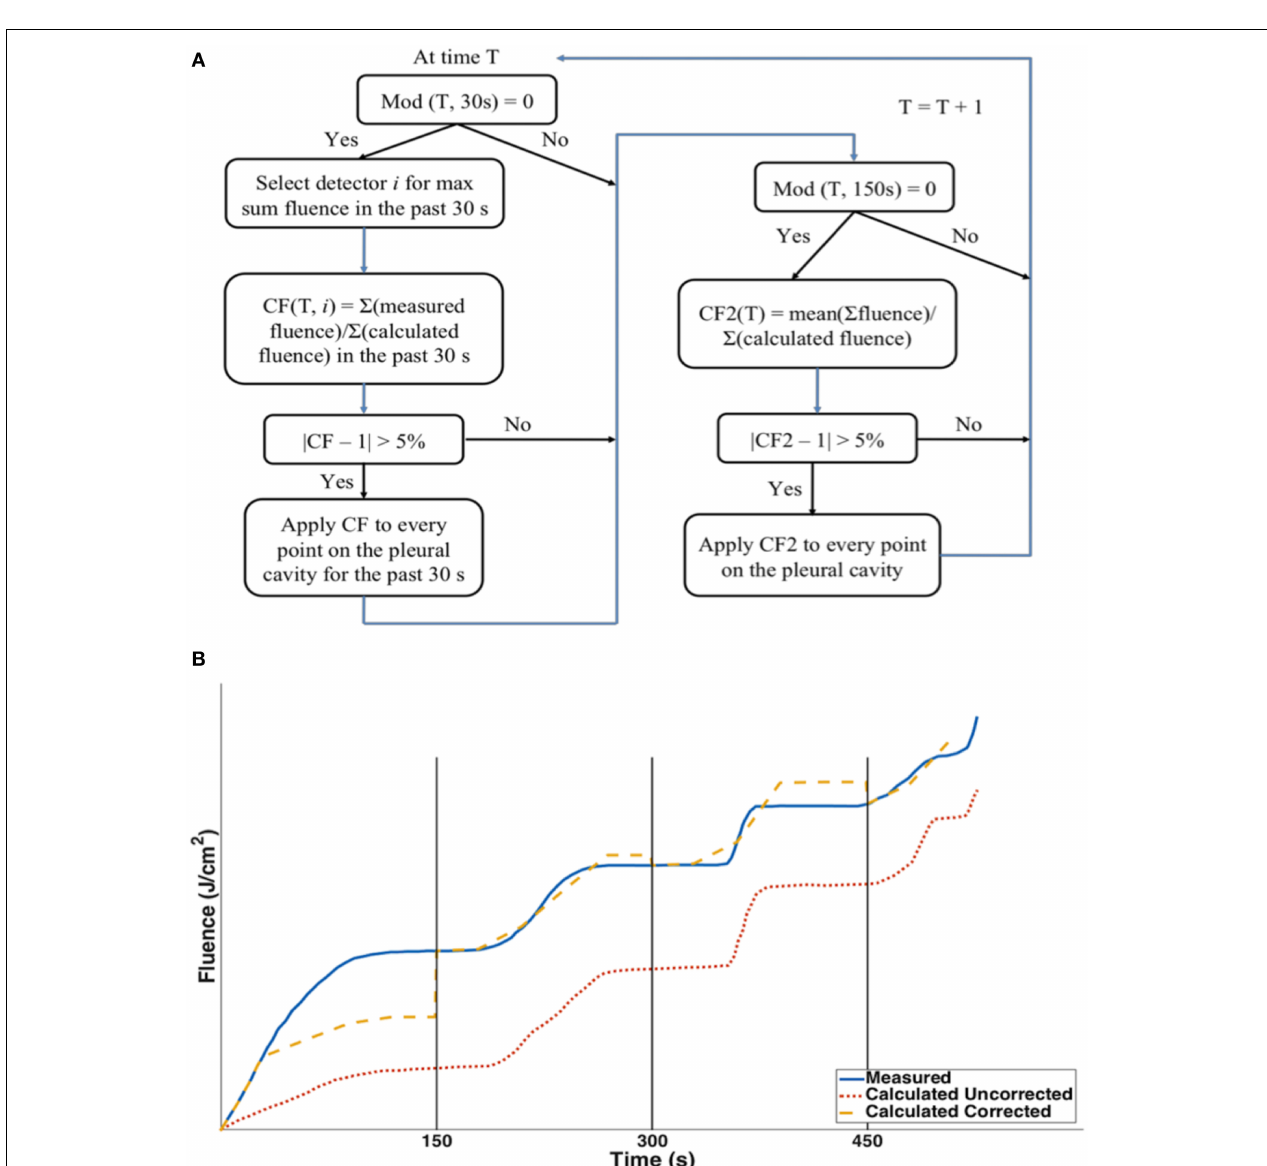
FIGURE 6 | (A) Dual correction schematics to modify the calculated light fluence to match the measured light fluence. The dual correction includes (1) the light fluence for each 30 second interval; (2) The total cumulative light fluence at 150s interval. Correction is